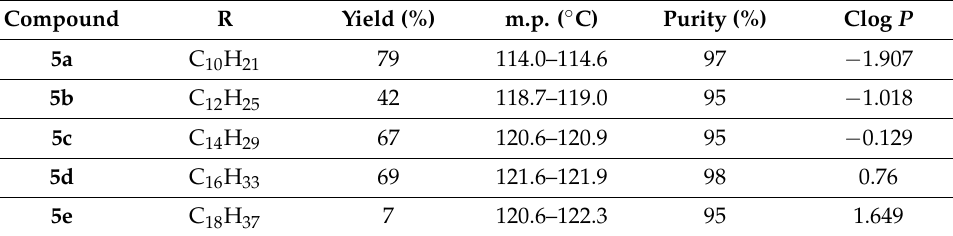
Table 1. Synthesis of BOC-like salts.